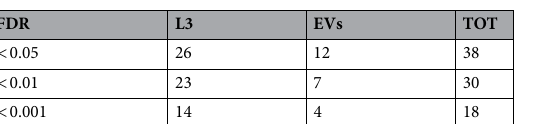
FDR L3 EVs TOT < 0.05 26 12 38 < 0.01 23 < Table 3. Number of differentially expressed miRNAs in Anisakis pegreffii larvae and released extracellular vesicles, according to three levels of statistical significance.